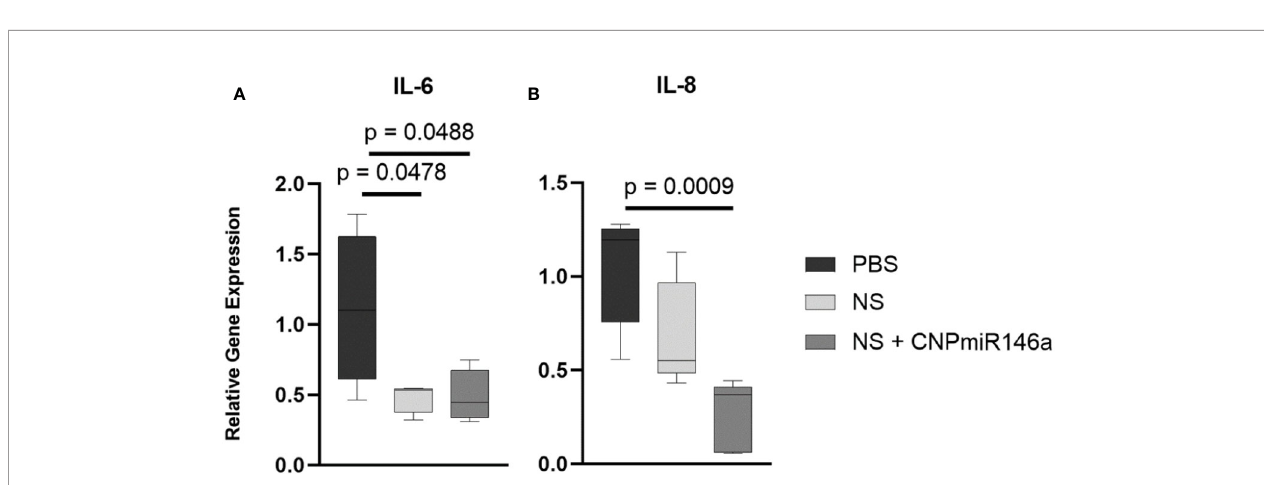
FIGURE 6 | CNP-miR146a, when delivered topically with nanosilk solution, signi fi cantly lowers early pro-in fl ammatory gene expression of IL-6 (A) , p = 0.0488) and IL-8 (B) , p = 0.0009) 7 days after injury. Nanosilk alone also lowered IL-6 gene expression (A) , p = 0.0478) 7 days into